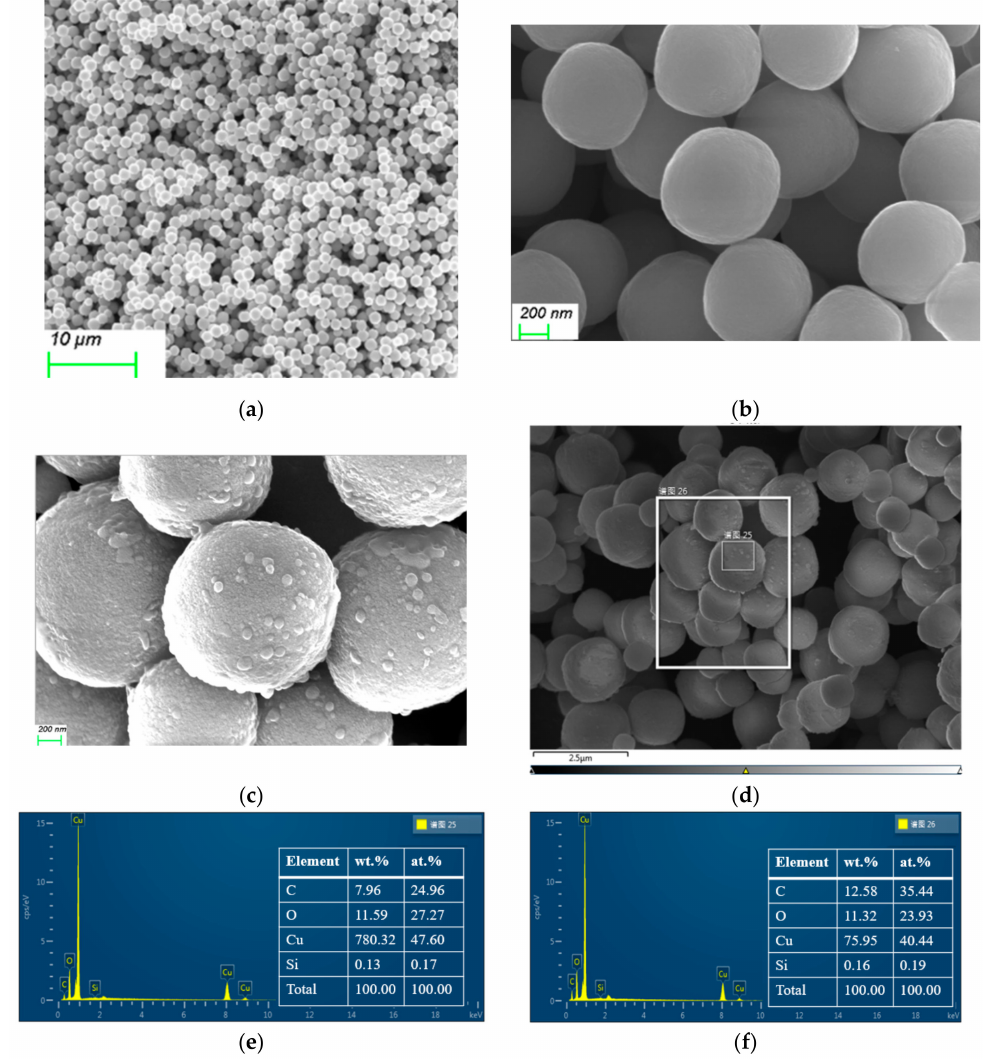
Figure 2. Scanning electron microscopy (SEM) image of ( a , b ) 0-Cu 2 O, ( c ) M-Cu 2 O, ( d – f ) EDS / SEM mapping for select